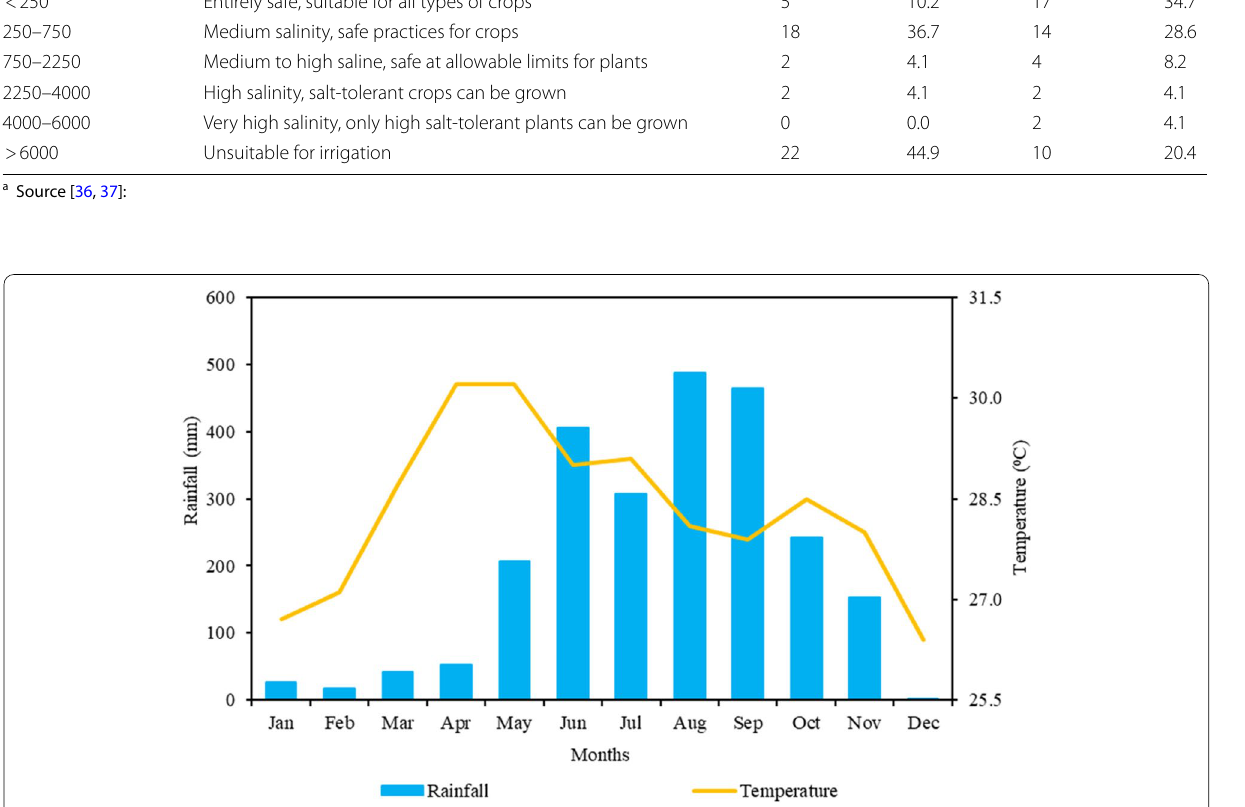
Fig. 4 Trends in ambient temperature and precipitation in Kien Giang province in